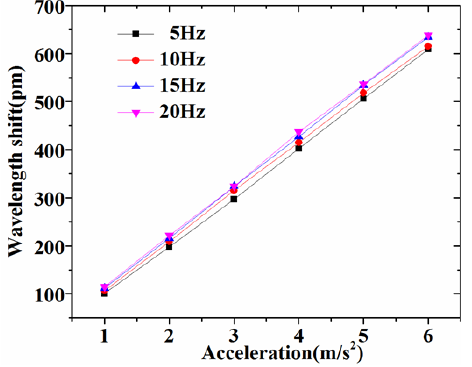
Figure 7. Responses of the sensor under different excitation accelerations.